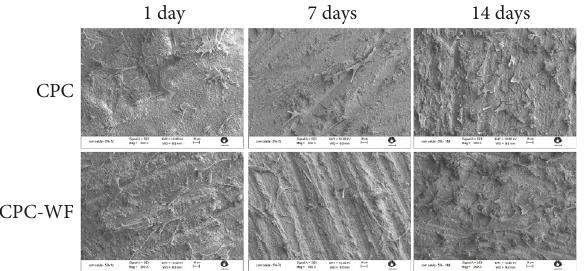
Figure 3: Alkaline phosphatase activity after 7, 10, and 14 days of culture. Negative control represents cells induced to differentiate and cultured in the well plate. 𝑝 values of < 0.01 are indicated by an